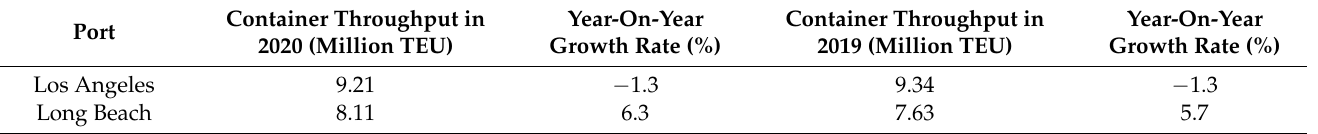
Table 3. The ports of Los Angeles and Long Beach container